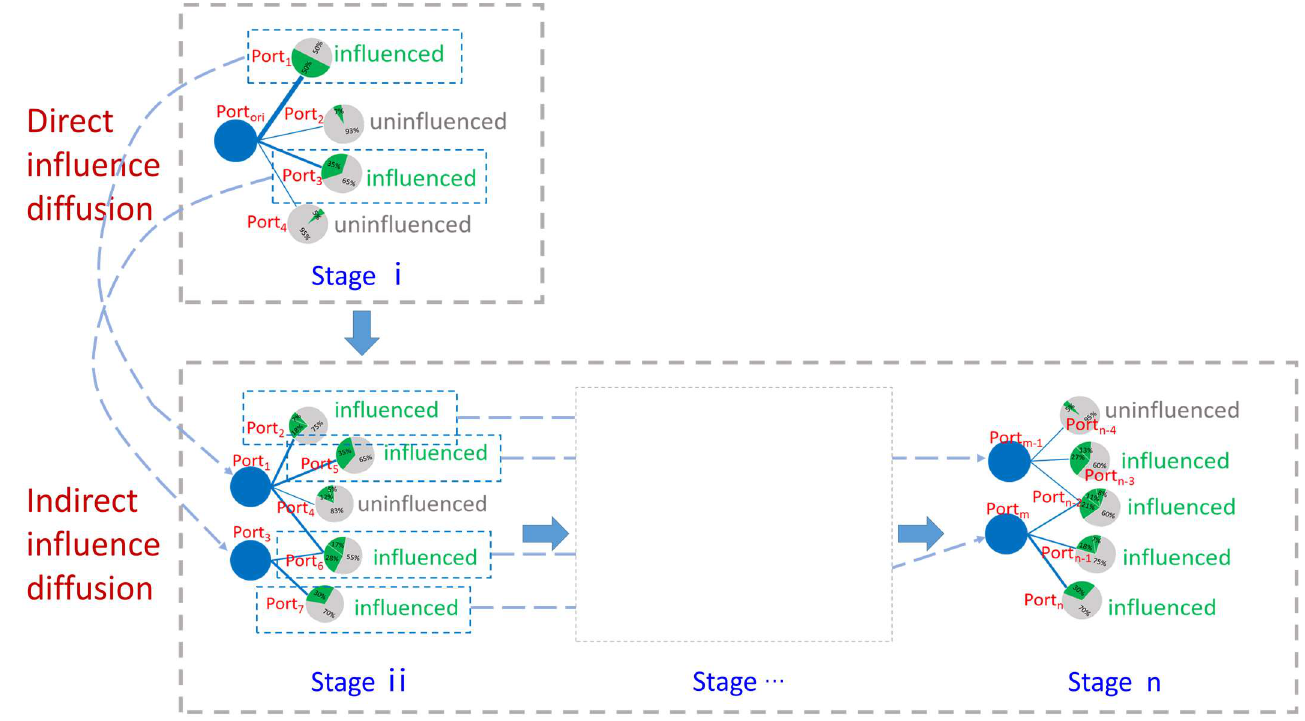
Figure 1. Schematic diagram of port influence diffusion model.